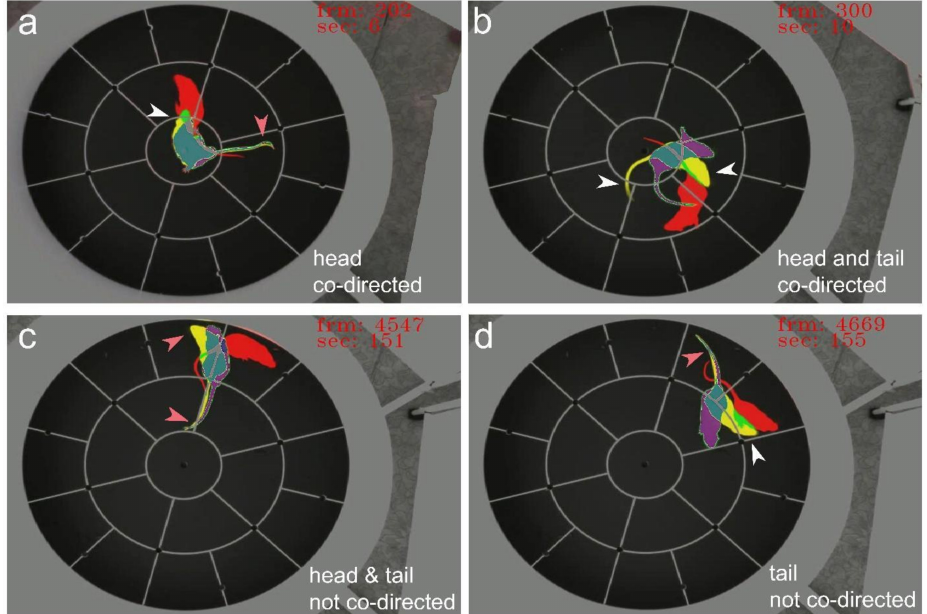
Figure 3. Examples of head and tail co-directional or non-co-directional positions regarding the future animal movement, revealed using temporal color-coding. For the time- and color-coding details, see the main text and the Figure 2 caption. ( a ) Head co-directed. ( b ) Both head and tail co-directed. ( c ) Both head and tail not co-directed. ( d ) Tail not co-directed. White arrowheads highlight co-directional positions and red arrowheads show non-co-directional